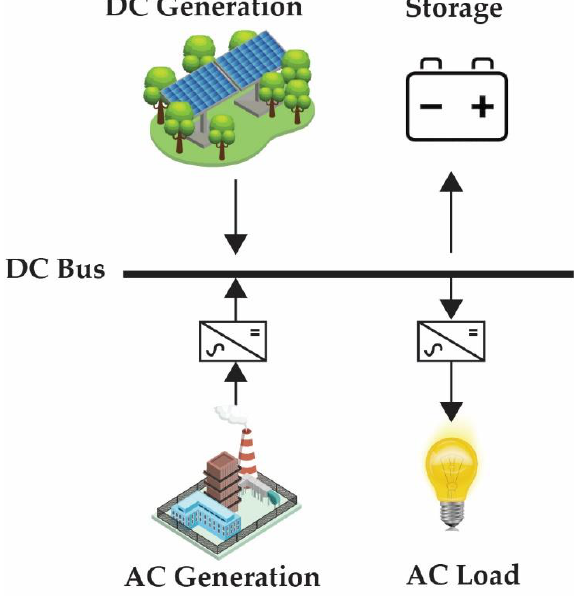
Figure 5. DC bus architecture of campus microgrids.